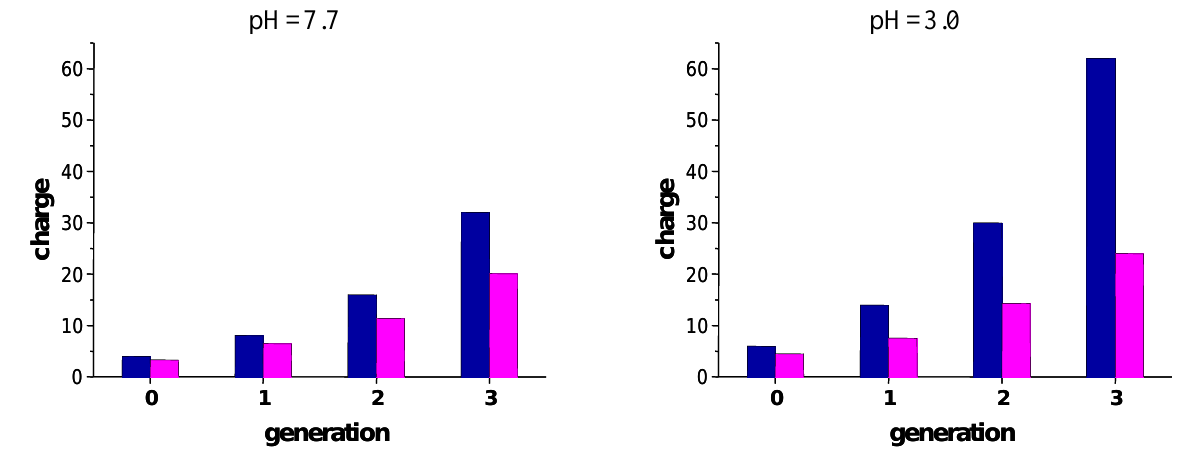
Figure 4. Comparison of nominal charge (blue) and effective charge (pink) PAMAM dendrimers for generations 0 to 3. On the left pH = 7.7 the primary amino groups are protonated while the tertiary amino groups are unprotonated. On the right pH = 3 all amino groups are protonated, the nominal charge is the sum of the primary and tertiary amino groups. pH=7.7